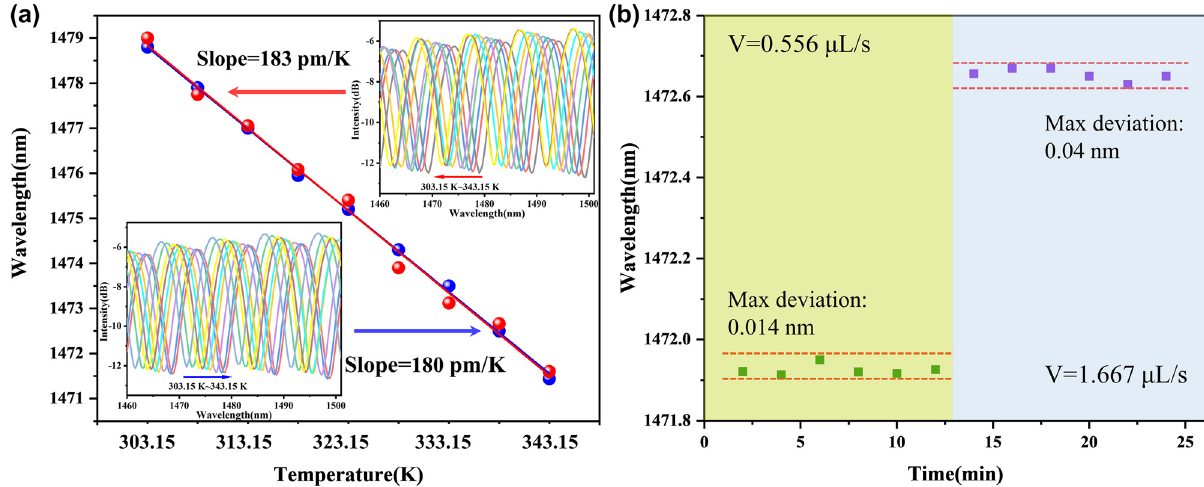
Figure 9: Temperature response and stability test: (a) Temperature characteristic of the sensor probe. (b) Stability test under flow velocity of 0.556 μ L/s and 1.667 μ